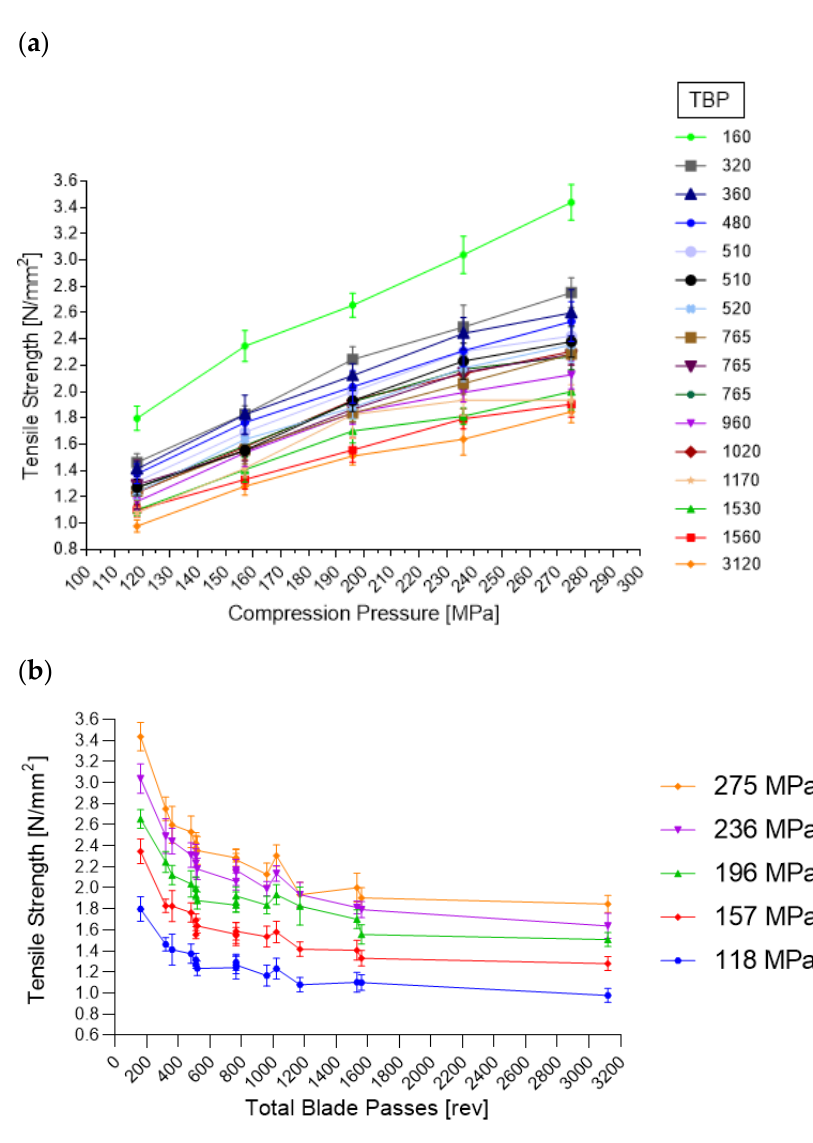
Figure 19. ( a ) Overview of all phases (TBP) regarding compression pressure and tensile strength. ( b ) Overview of all compression pressures and the corresponding tensile strength based on the lubrication (TBP). Table 10. Overview of fit statistics regarding tensile strengths obtained during compression-force profiles.